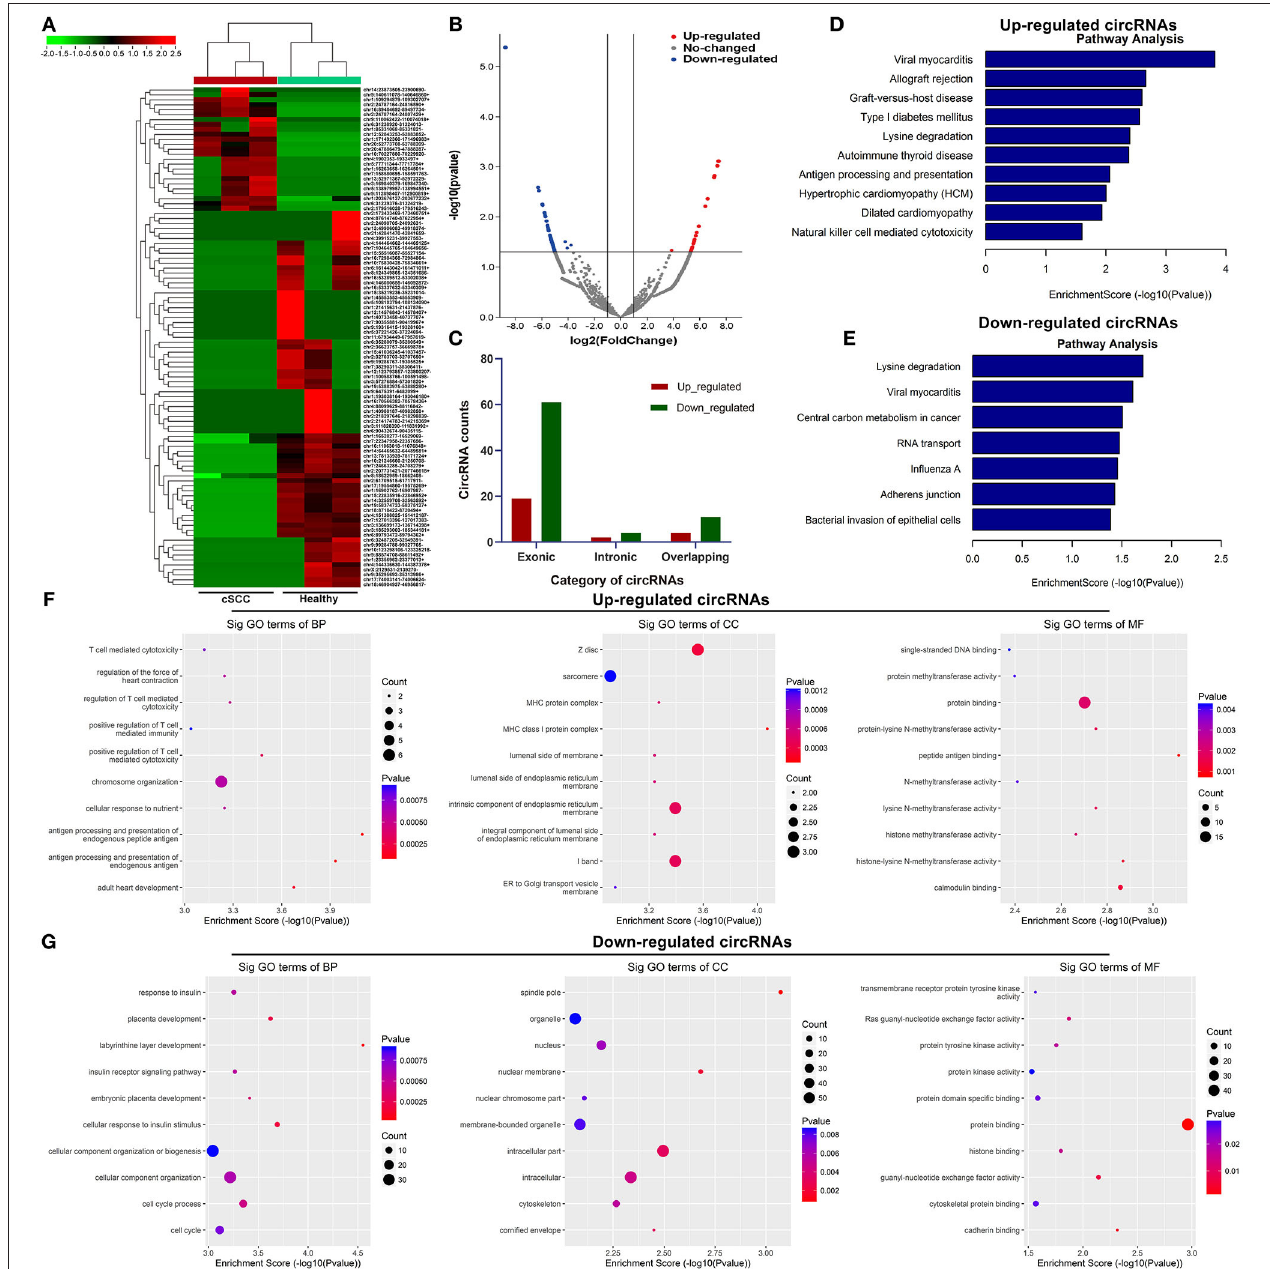
FIGURE 2 | Identification of exosomal circRNAs and their functions in cSCC. (A) Heatmap for the up- (red) and down-regulated (green) exosomal circRNAs between cSCC and healthy individuals. (B) Volcano plots of up- (red) and down-regulated (blue) circRNAs between cSCC and healthy individuals. (C) Category of differentially expressed circRNAs. (D,E) KEGG pathway enrichment results of up- and down-regulated circRNAs. (F,G) GO annotation results of up- and down-regulated circRNAs.